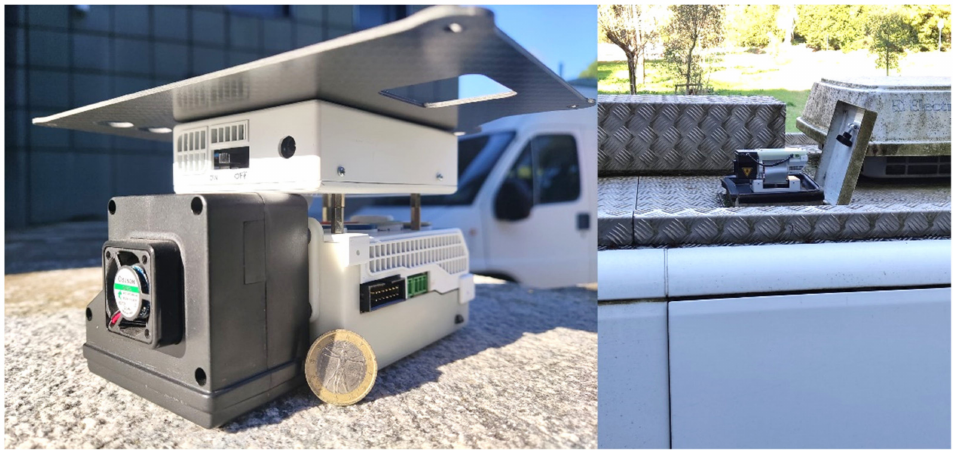
Figure 1. Air monitoring payload and its location on the roof of the